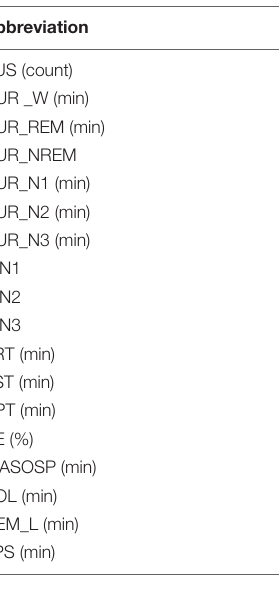
TABLE 1 | Abbreviations and definition of sleep